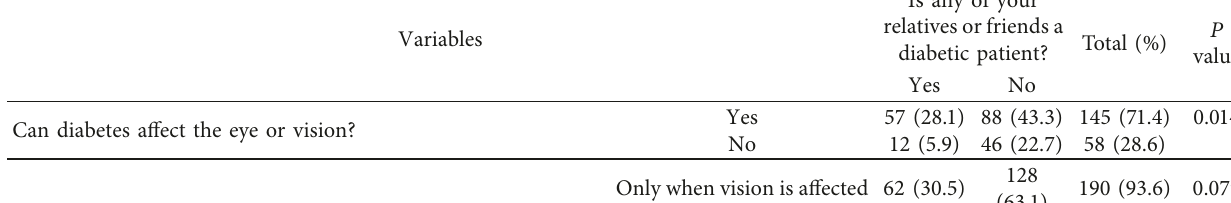
Table 5: Association between the diabetic status of patients’ close relations and their knowledge and awareness of DM and DR. Variables